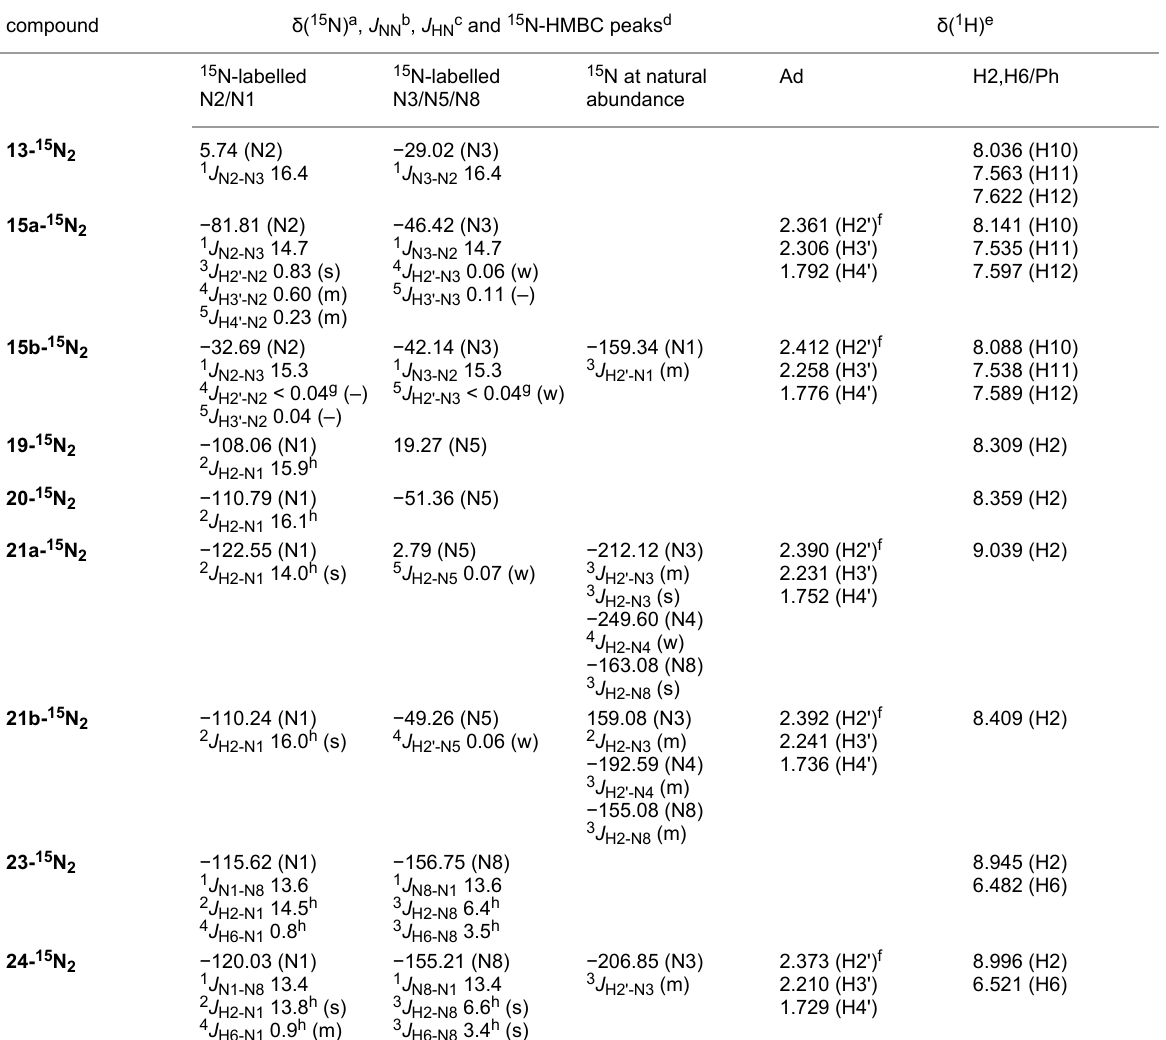
Table 1: 1 H and 15 N chemical shifts (ppm), 1 H- 15 N and 15 N- 15 N J -coupling constants (Hz), and 1 H- 15 N spin–spin interactions observed in the 2D 15 N-HMBC spectra of the synthesized compounds.